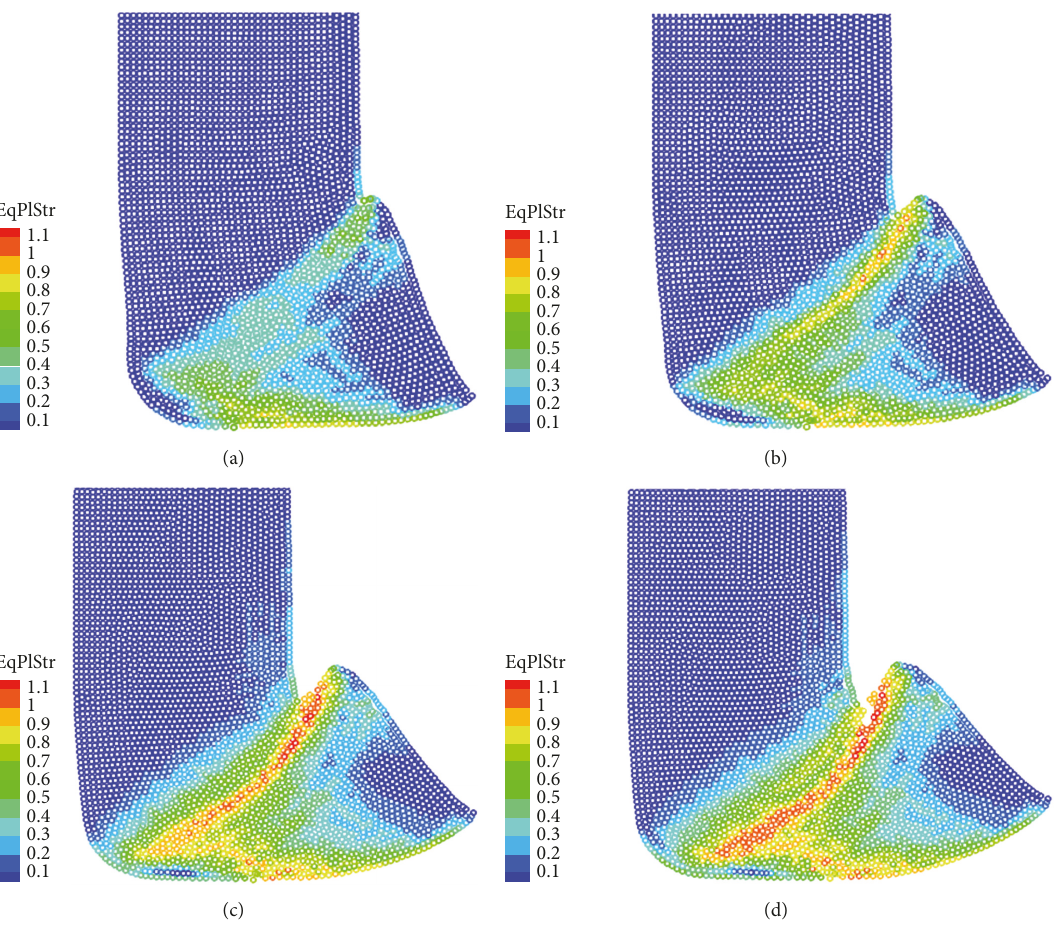
Figure 7: Simulation results of equivalent strain